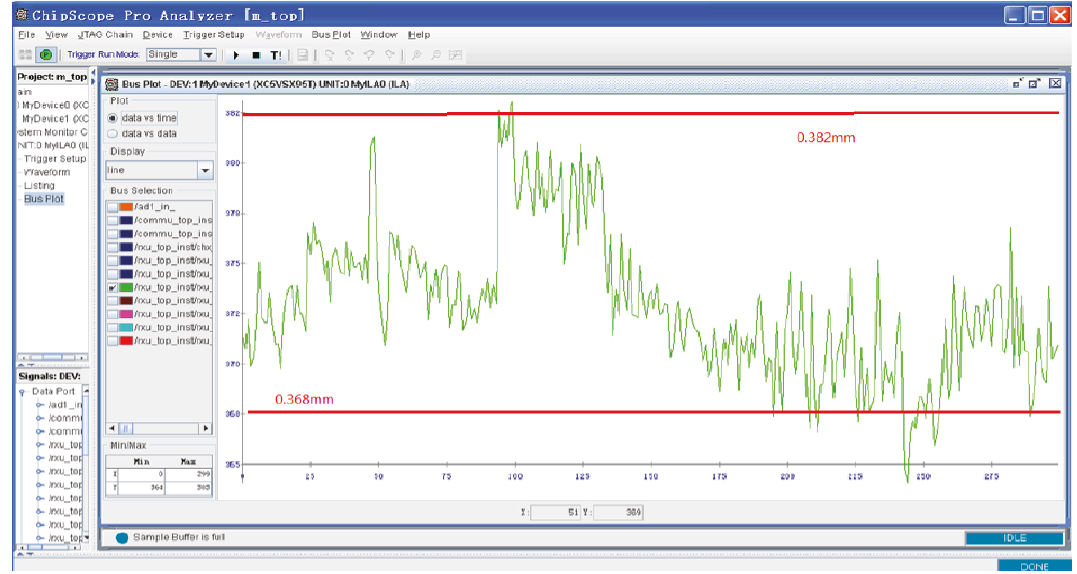
Figure 12: Results of ranging precision by ChipScope. Table 2: Antenna coordinates of both